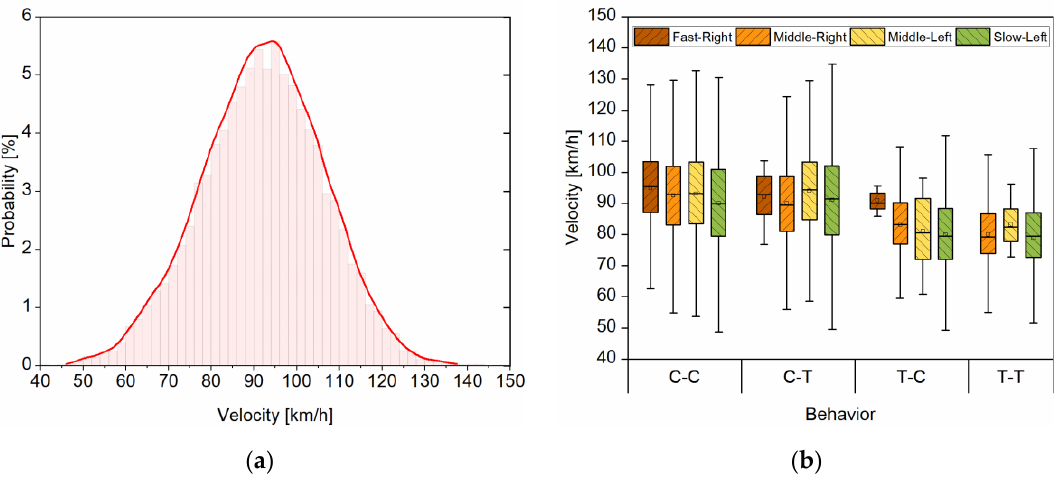
Figure 5. ( a ) Probability distribution of m velocity; ( b ) Velocity in different car follow types and lane change types.